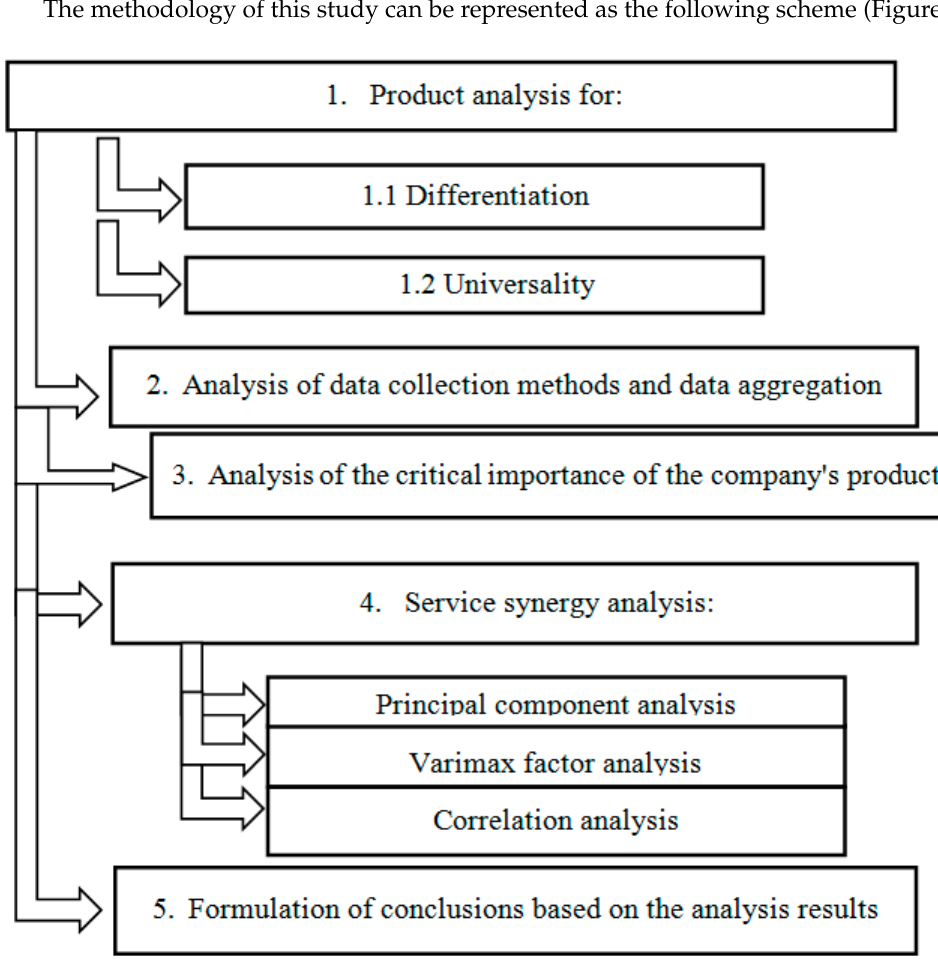
Figure 1. The methodological framework of the study.